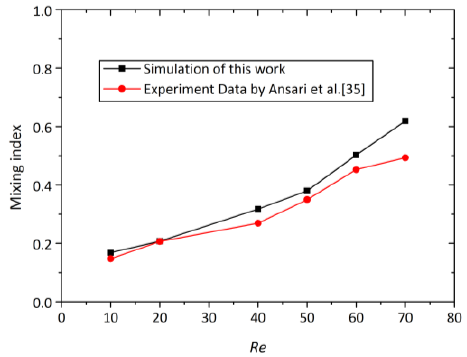
Figure 4. Comparison of the mixing index of the simulation results with the experimental data by Ansari et al. [35].